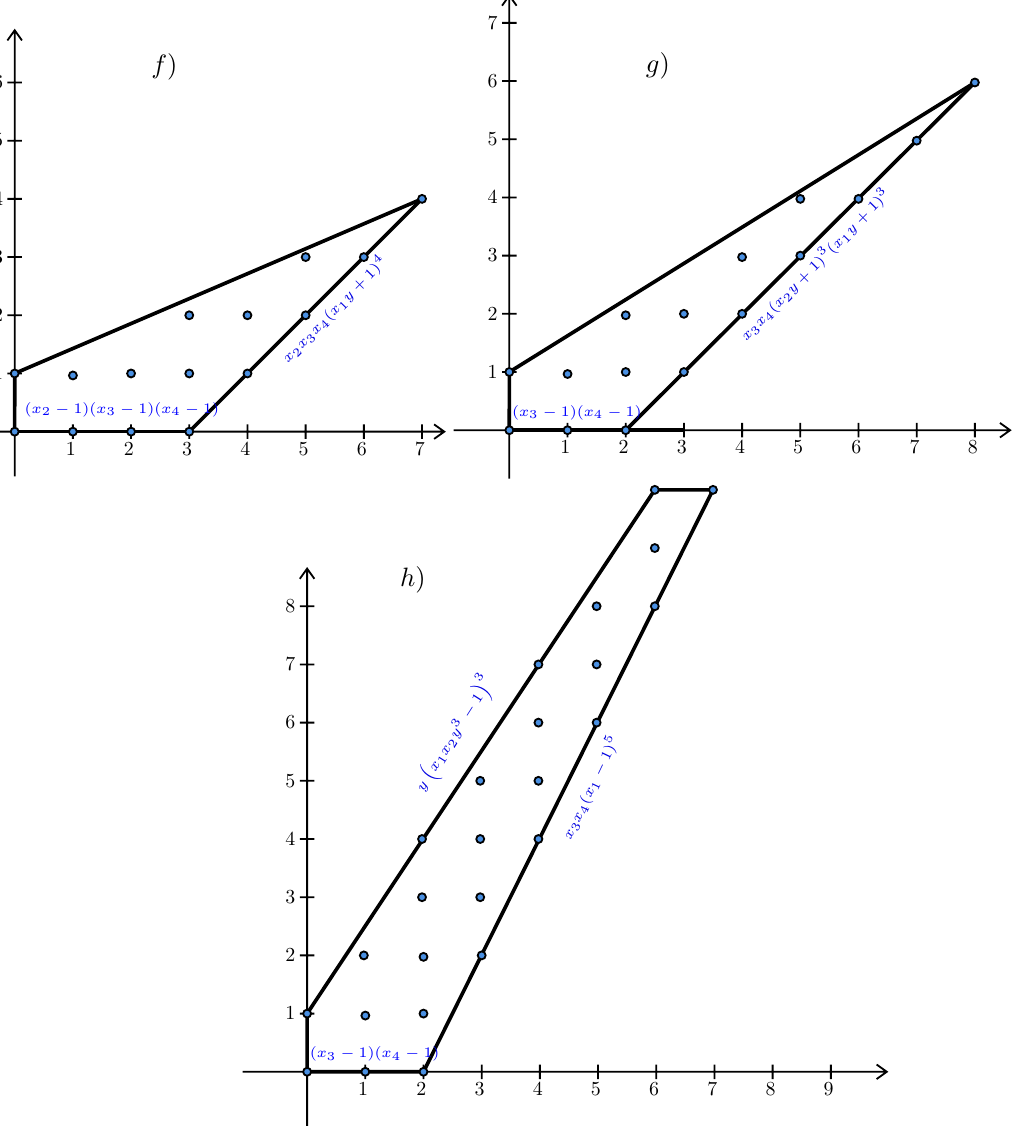
Figure 29 . Newton polygons and face polynomials for the examples f ) ; g ) ; h